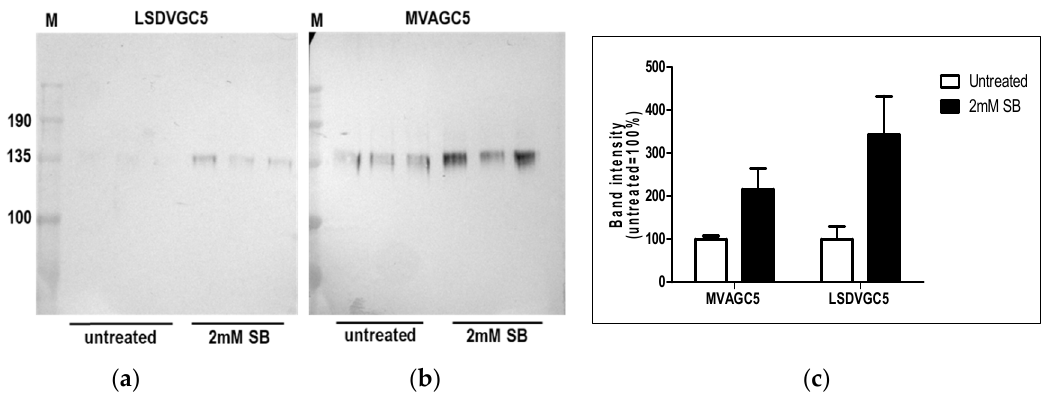
Figure 5. Expression of HIV-1 Env from nonpermissive HEK292T cells infected with LSDVGC5 or MVAGC5 in the presence and absence of 2 mM sodium butyrate. Cell lysates were prepared in triplicate 72 h post infection with LSDVGC5 ( a ) or MVAGC5 ( b ) and subjected to western blot analysis. Densitometry readings were plotted using GraphPad Prism 5 ( c ).